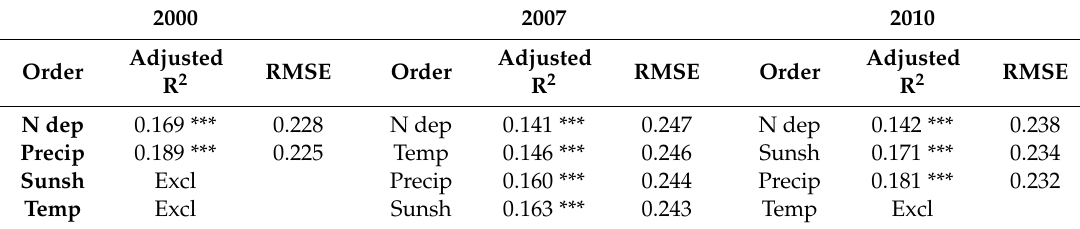
Table 6. Order of variables entered into the model and adjusted R 2 for croplands / natural vegetation mosaics according to the addition of a new variable to the model: N deposition: N dep, Temp: Temperature, Precip: Precipitation, and Sunsh: Sunshine. Excl: Variable excluded from the model. *** Statistically significant p <